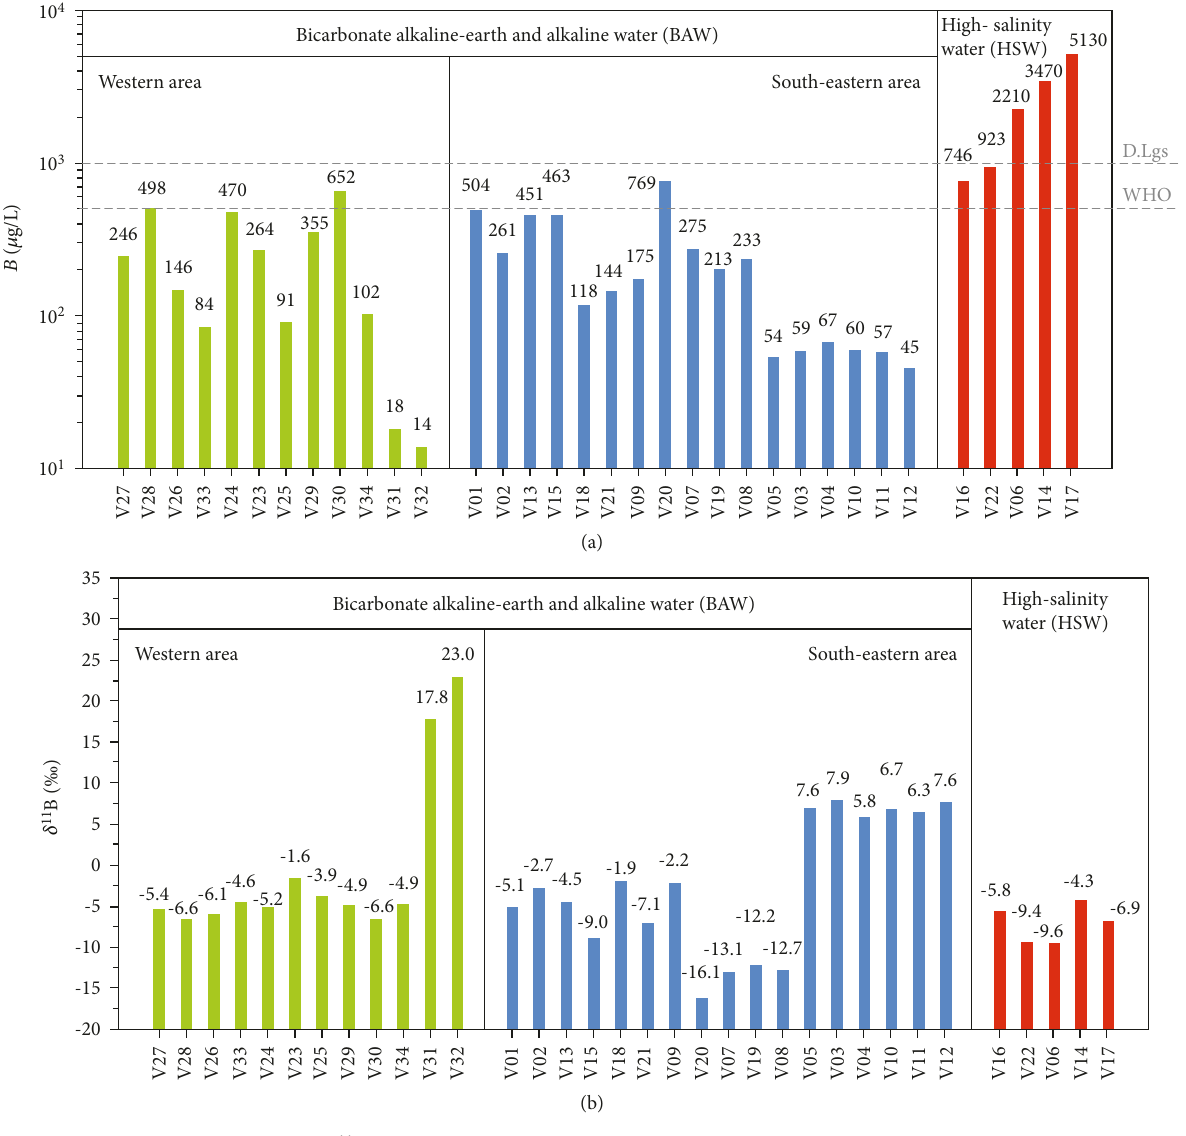
Figure 3: Boron concentrations (a) and δ 11 B values (b) of the Mt. Vulture groundwaters divided into bicarbonate alkaline-earth and alkaline (BAW) and bicarbonate-sulphate-alkaline (high-salinity water (HSW)) water